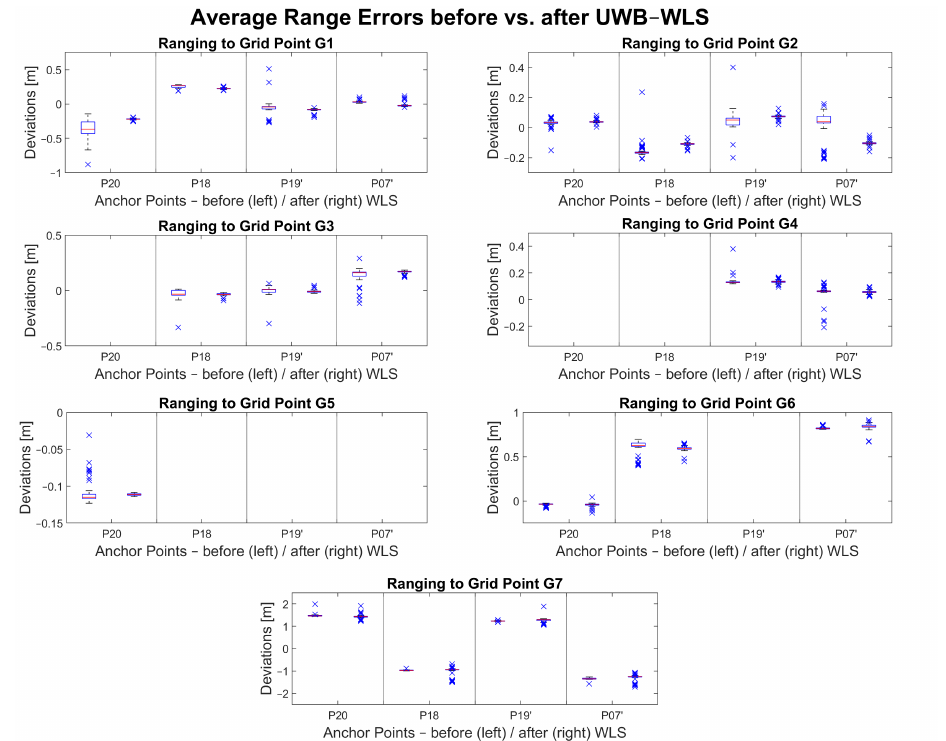
Figure 12. UWB range errors before and after UWB-only WLS